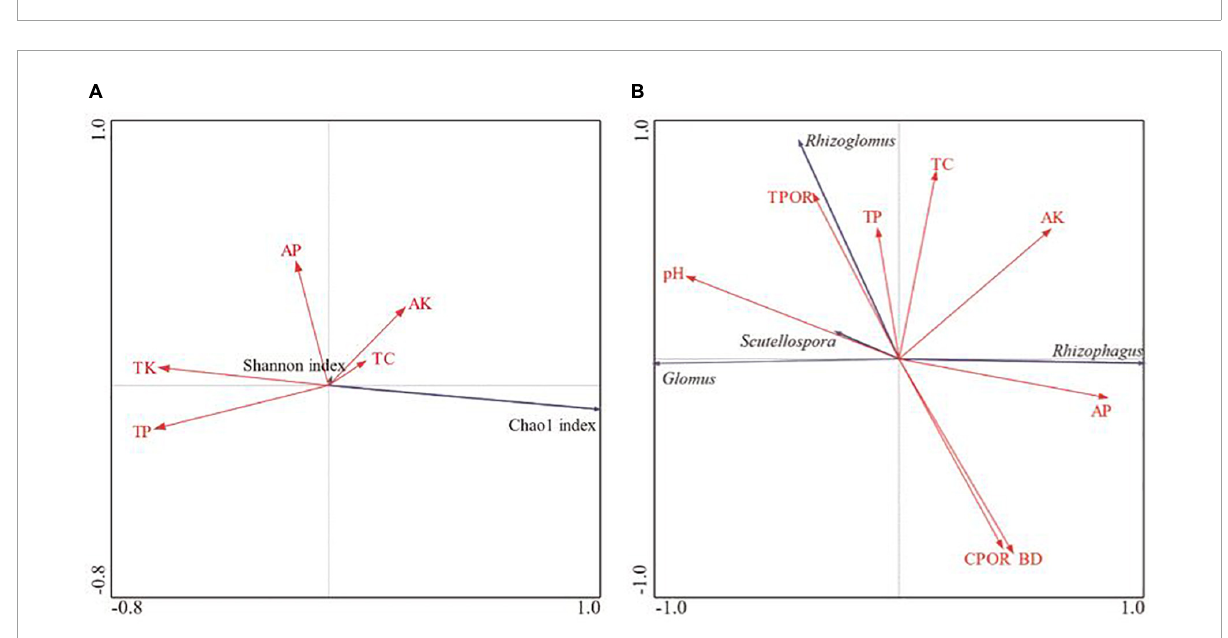
FIGURE9 Correlation analysis of soil physical and chemical properties with AMF diversity index (A) and relative abundance (B) in bulk soils.